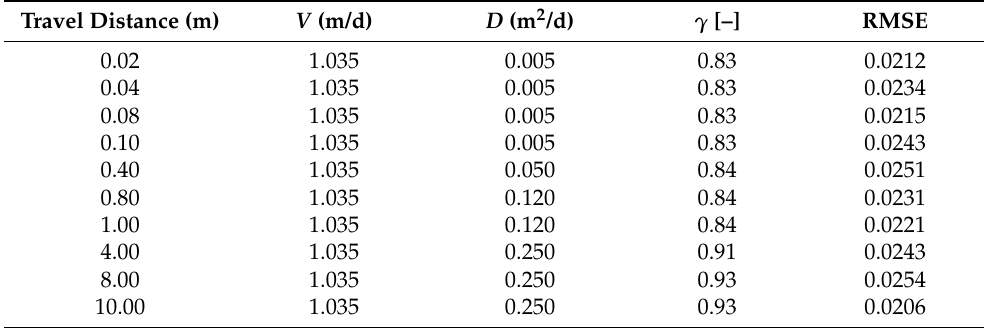
Figure 6. Fracture: The change of the time index γ in the FADE (7a) with the travel distance for fitting the Breakthrough curves (BTCs) shown in Figure 5. The dashed line shows the asymptote. ( b ) is the semi-log plot of ( a ).